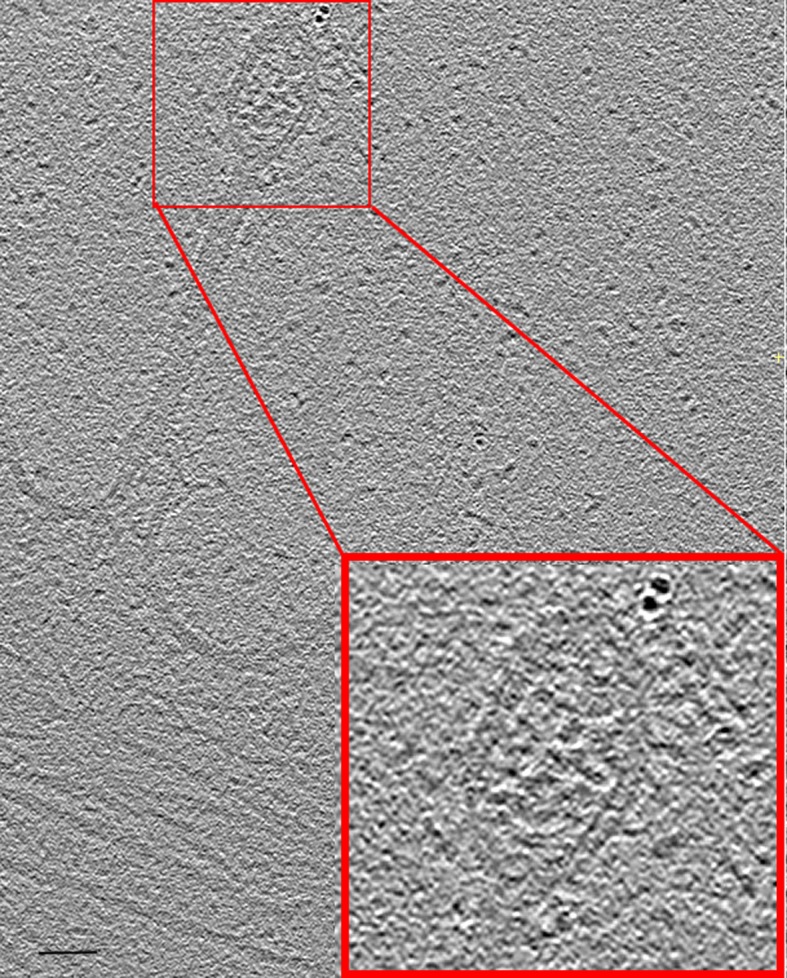
AuNPs characteristic footprint in a tomogram slice.Tomogram slice showing a pair of gold nanoparticles associated with cell surface. Bar 10 nm. Lower right corner, boxed area zoomed out two fold.